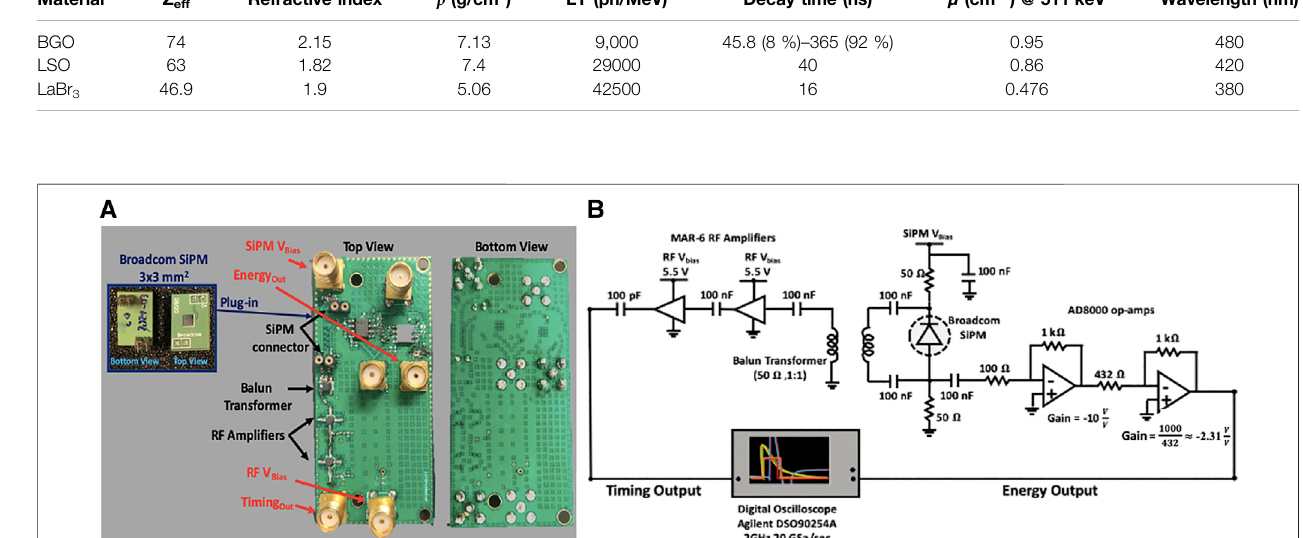
TABLE 1 | Main properties of BGO, LSO, and LaBr 3 [28, 30].